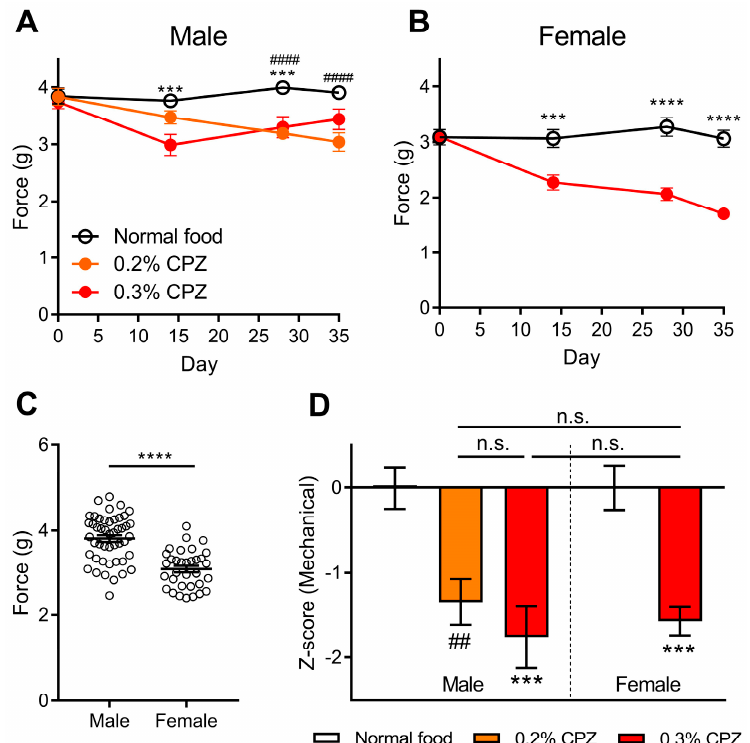
Figure 2. Cuprizone administration decreased mechanical sensitivity threshold in male and female C57BL/6J mice. Mechanical sensitivity was measured using an electronic von Frey aesthesiometer. In ( A ) male and ( B ) female mice, cuprizone (CPZ) administration led to a decrease in the mechanical threshold. Two-way ANOVA with Bonferroni post-tests. ( C ) In a comparison between all mice on day 0, it was found that female mice have a lower threshold than male mice. ( D ) The z-score analysis normalised the results to the corresponding normal food control. All doses of cuprizone led to a decrease in mechanical threshold with no sex or dose-dependent effects. ( A , B ) Two-way repeated-measures ANOVA with Bonferroni post-tests. ( C ) Unpaired t -test. ( D ) One-way ANOVA with Bonferroni post- tests. ## p < 0.01, #### p < 0.0001 for 0.2% cuprizone vs. normal food. *** p < 0.001, **** p < 0.0001 for 0.3% cuprizone vs. normal food, or as indicated. n.s. = not significant. Data presented as mean ± SEM. n =